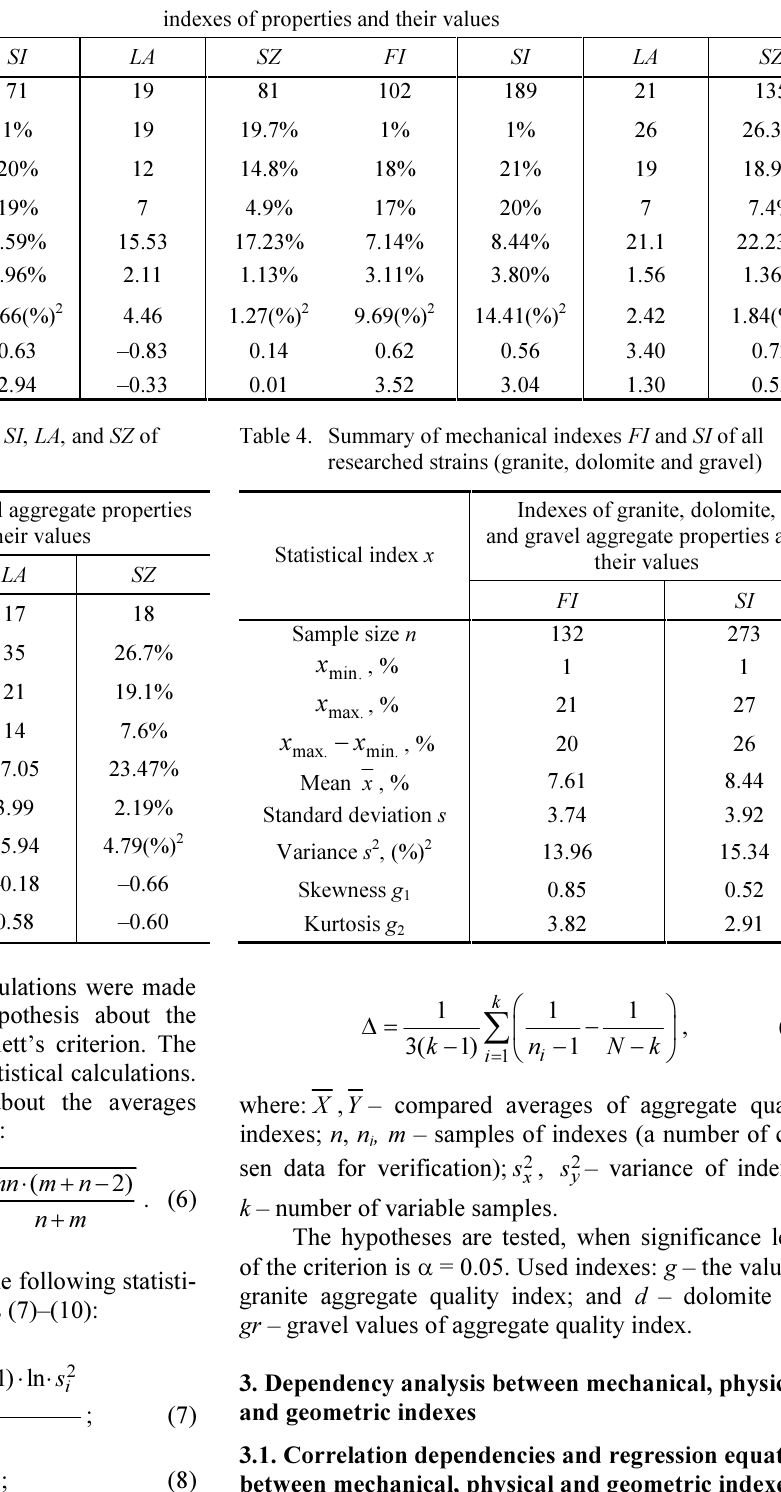
Table 2. Summary of mechanical indexes FI, SI , LA, and SZ of granite and dolomite aggregate Statistical index x